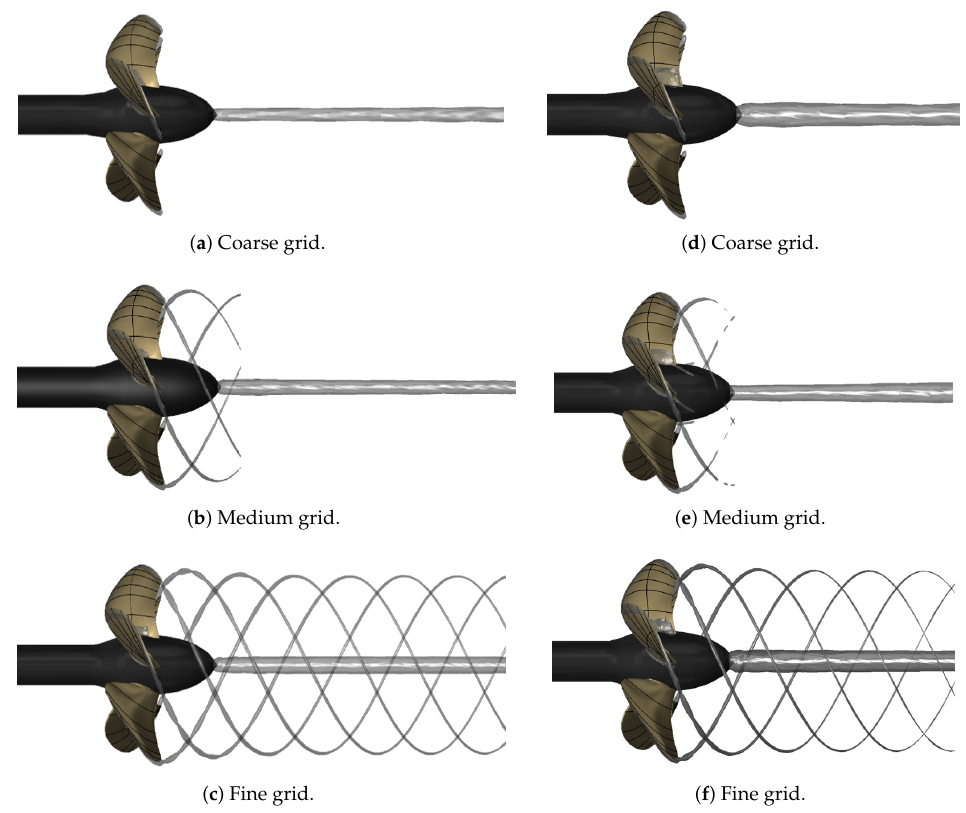
Figure 13. Comparison of cavitation patterns for the PPTC propeller with different grid densities. On the left: model-scale simulations. On the right: full-scale